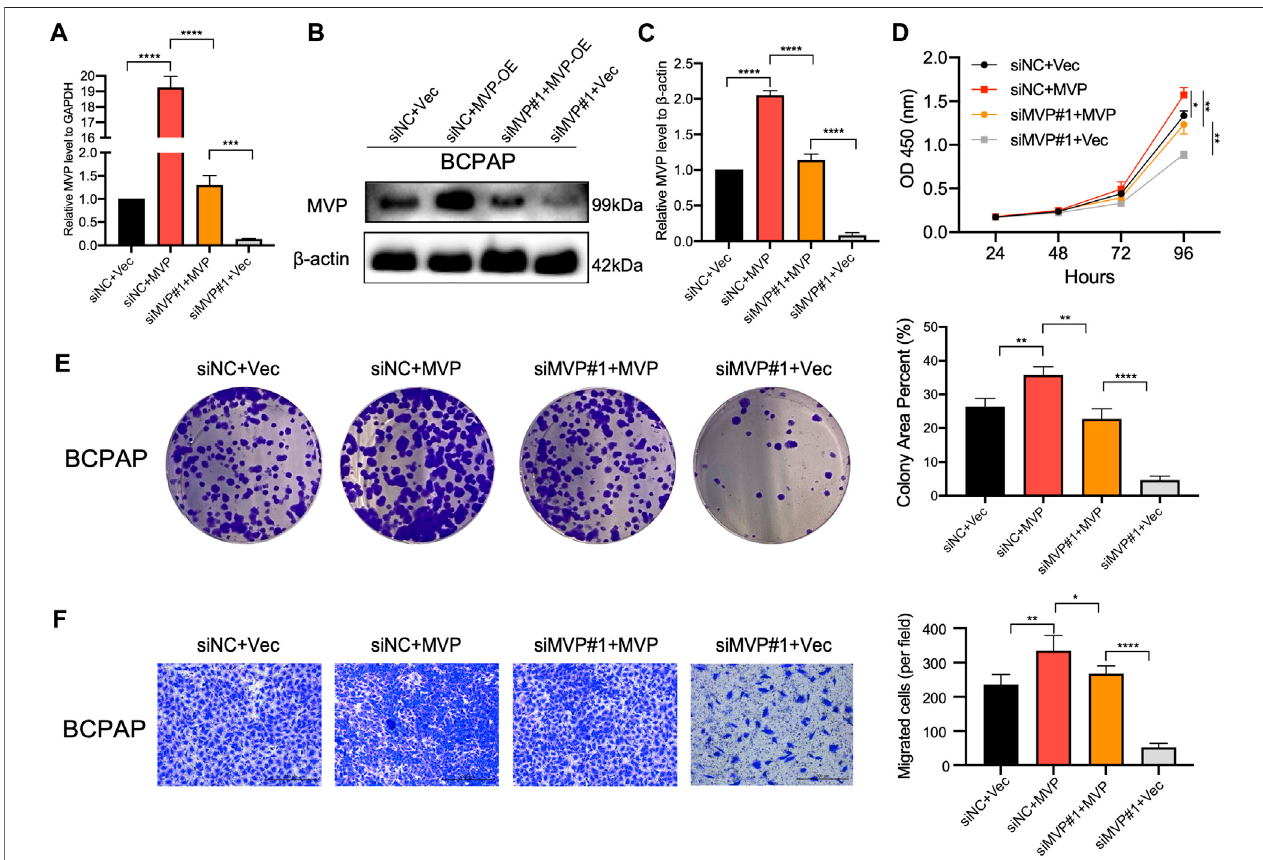
FIGURE 10 | Rescue experiment indicated MVP maintains the survival and migration of PTC cells. (A – C) MVP expression was rescued in MVP silenced BCPAP cells. (A) qPCRand (B,C) WesternblottingassayswasperformedtodetectrelativeexpressionlevelofMVP. (D,E) CCK-8andcolonyformationassayswereperformed totestcellproliferationoftheseBCPAPcells. (F) TranswellassayswereperformedtotestcellmigrationactivityoftheseBCPAPcellswithrestoredexpressionofMVP.All assays were independently repeated at least three times. Data are presented as the mean ± SD. * p < 0.05, ** p < 0.01, *** p < 0.001, **** p < 0.0001.